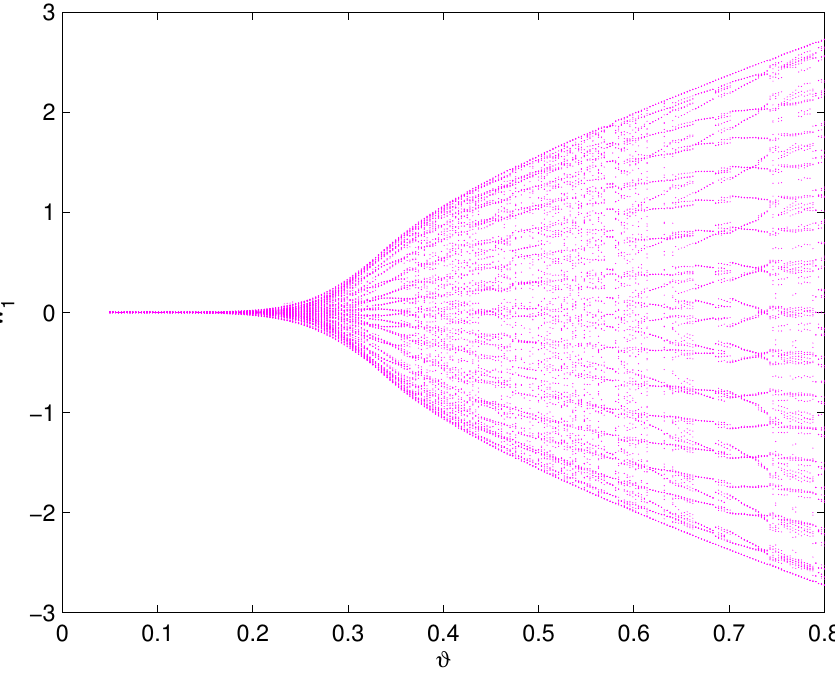
Figure 17. Bifurcation graph of system (73): the time delay ϑ versus the variable w 1 . The bifurcation number is